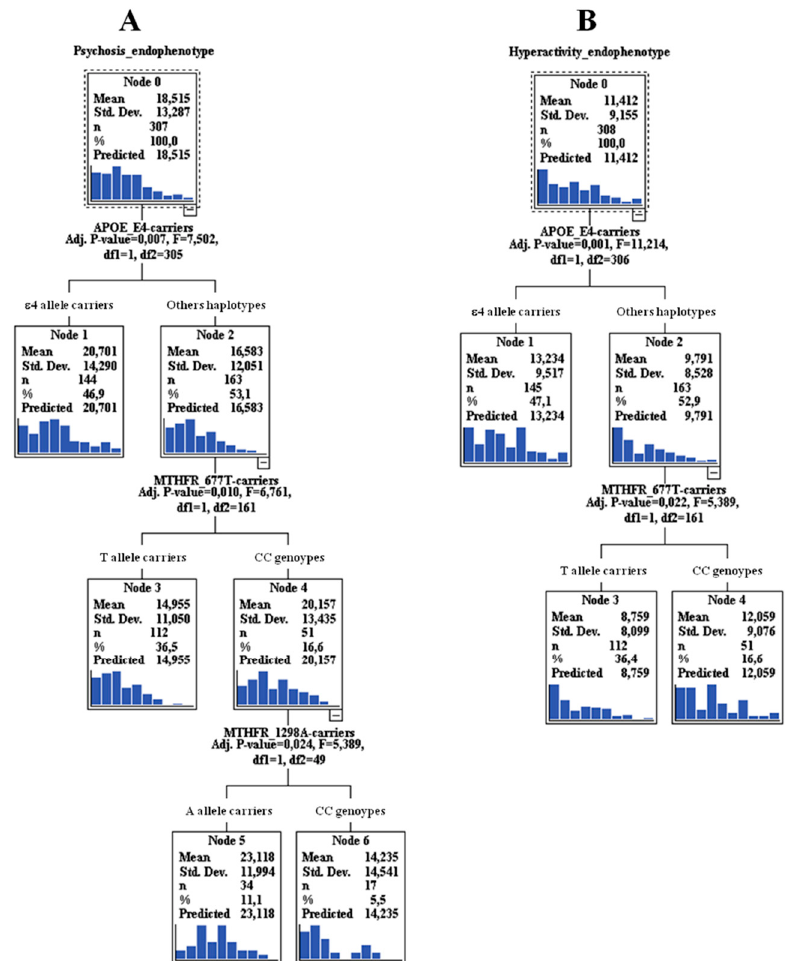
Figure 1. Exhaustive Chi-squared Automatic Interaction Detector (CHAID) data mining algorithm analysis results (“genexgene” interaction) for “Psychosis” ( A ) and “Hyperactivity” ( B ) endophenotypes. Note: Mean ± SD is given by the sum of the scores relative to “severity*frequencies” of the endophenotype components. For other haplotypes, we meant “ APOE ε 4 non-carriers”.